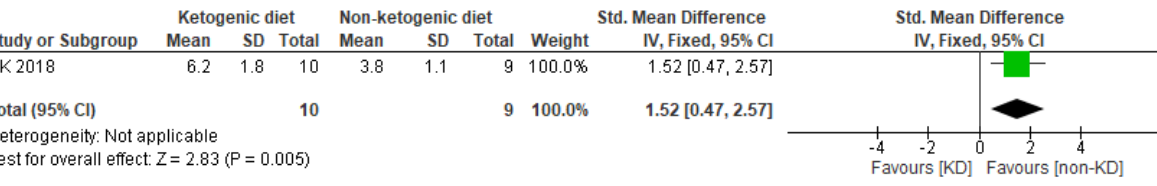
Figure 6. Forest plot of standardized mean difference in fixed effects model for ketosis in comparison of KD and non ‐ KD group.